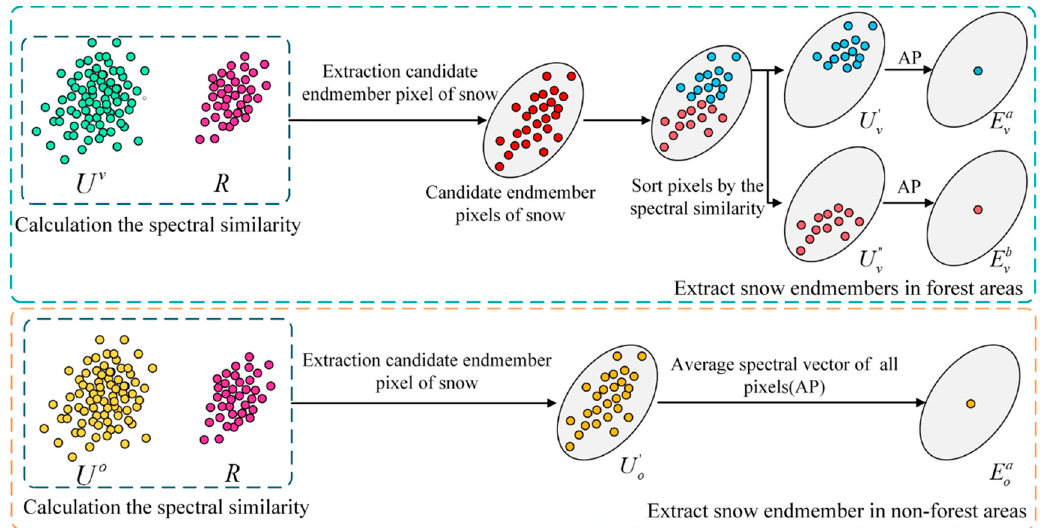
Figure 5. Extraction of snow endmembers in the forest and non-forest areas. E a o , E a v and E b v are snow endmembers, respectively. U (cid:48) o , U (cid:48) v and U (cid:48)(cid:48) v are candidate endmember sets of snow. U o and U v are the candidate endmember pixel sets in non-forest and forest areas. R is the spectral reference library of snow.